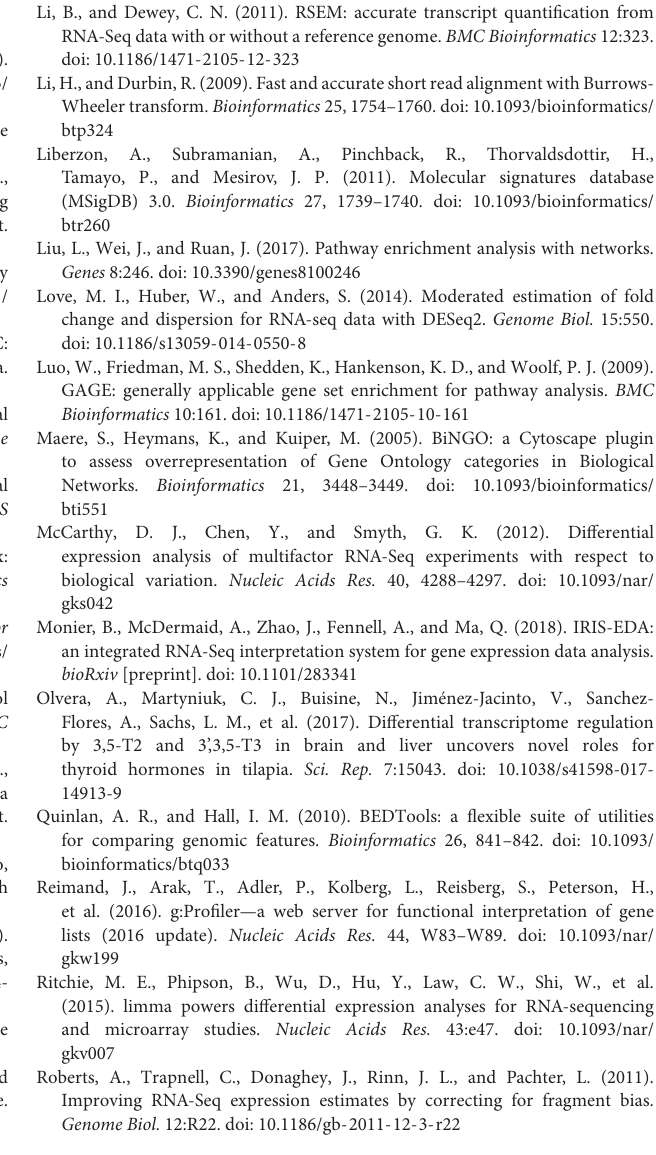
FIGURE S1 | Liver C vs. T3 MA plot. FIGURE S2 | Liver C vs. T3 MD plot. FIGURE S3 | Liver C vs. T3 smear plot. FIGURE S4 | Liver C vs. T3 heatmap. FIGURE S5 | Liver C vs. T3 statistic parameter correlogram. MATERIAL S1 | Raw count table. MATERIAL S2 | IDEAMEX user